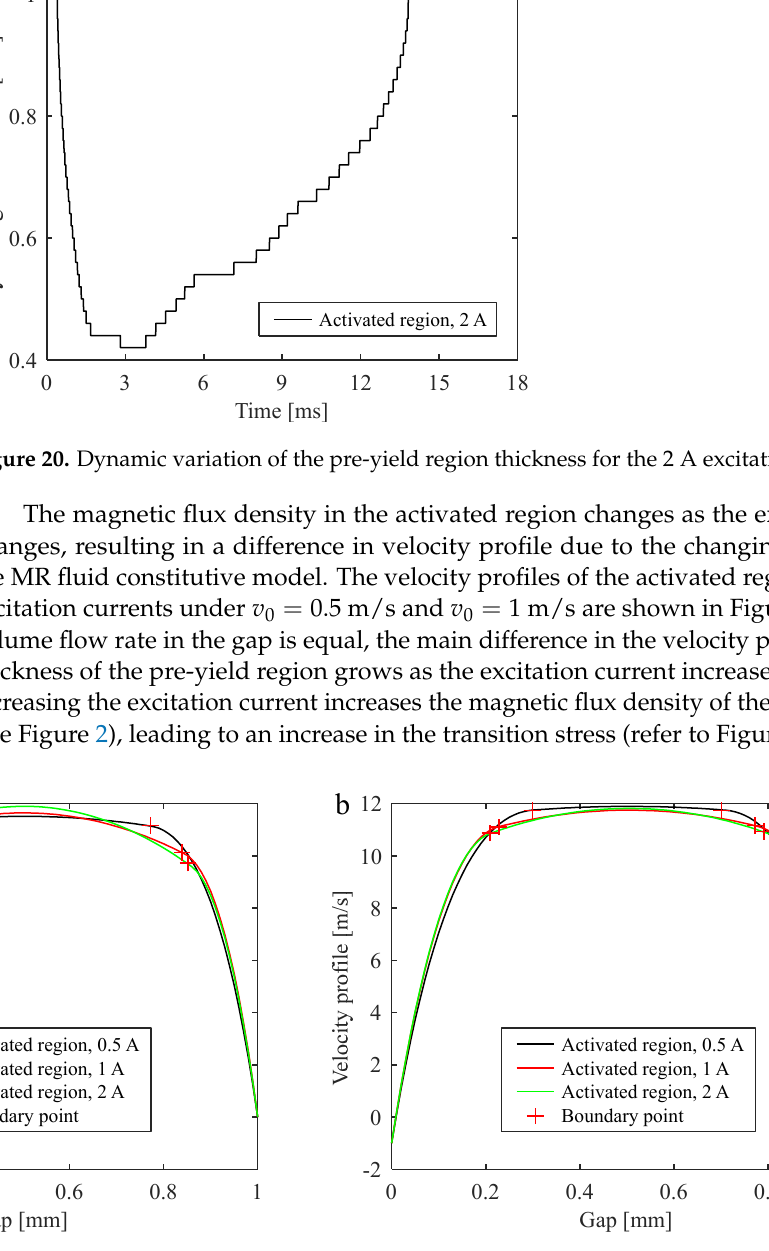
Figure 21. Velocity profiles of the activated region for different excitation currents under v 0 = 0.5 m/s and v 0 = 1 m/s .